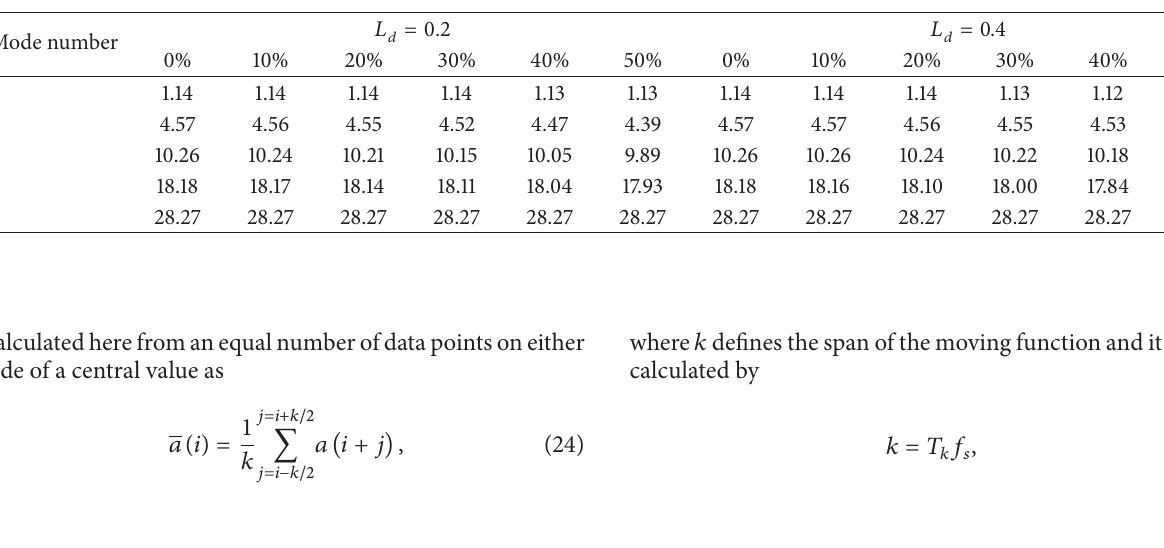
Figure 19: CPST of 10% damaged scenario using acceleration responses with the mass which is 200 Kg and velocity which is 1m/s: (a) damage location is 𝐿 𝑑 = 0.2 , (b) damage location is 𝐿 𝑑 = 0.4 , (c) damage location is 𝐿 𝑑 = 0.6 , and (d) damage location is 𝐿 𝑑 = 0.8 . Table 2: Natural frequencies (Hz) of different damage